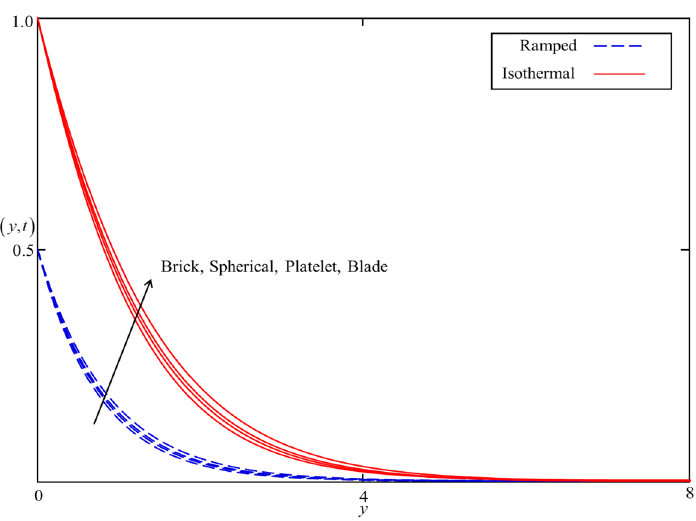
y , t when α = 0.5 , φ = 0.04 , Nr = 0.5 , (cid:30) (cid:31)